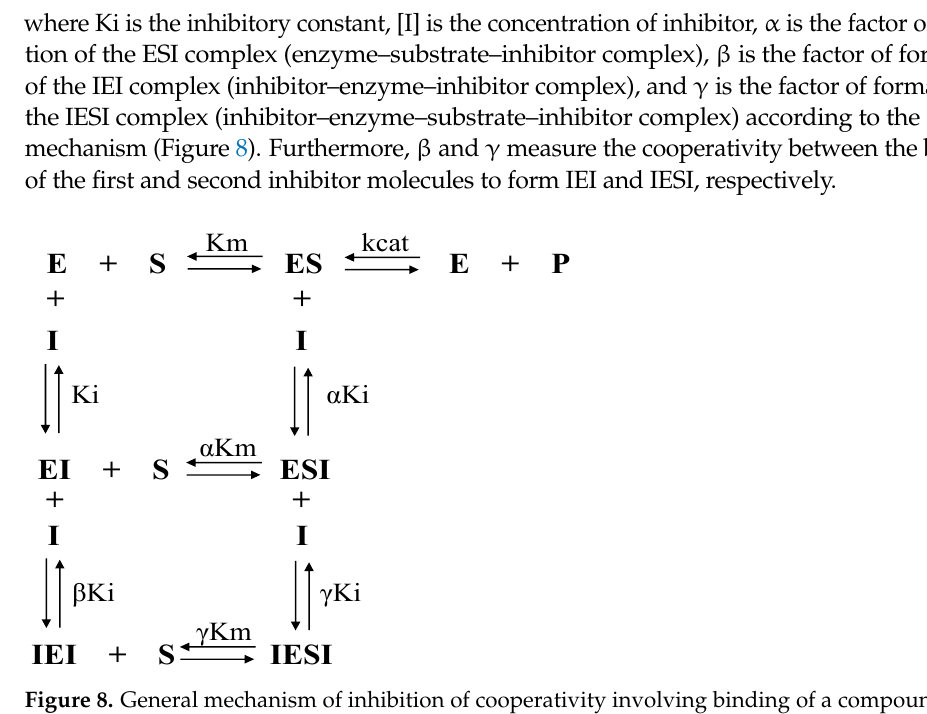
Figure 8. General mechanism of inhibition of cooperativity involving binding of a compound to the free enzyme E and the ES complex.